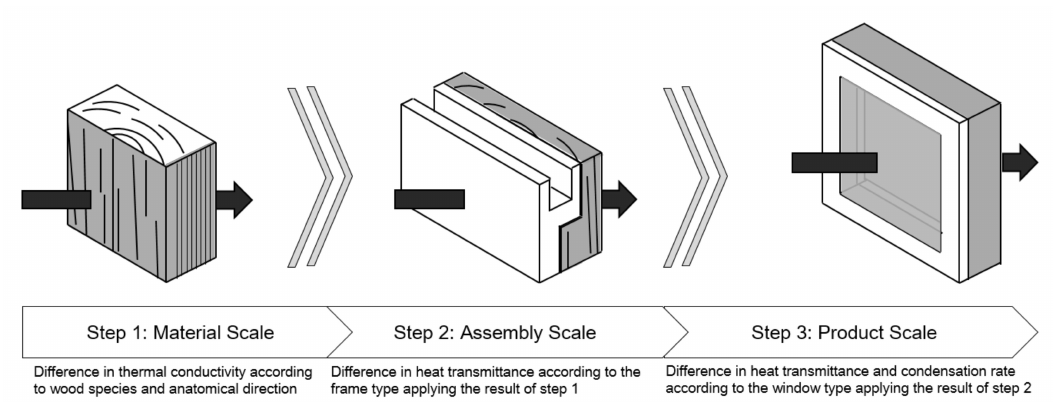
Figure 1. Research workflow: from raw material to frame assembly to product